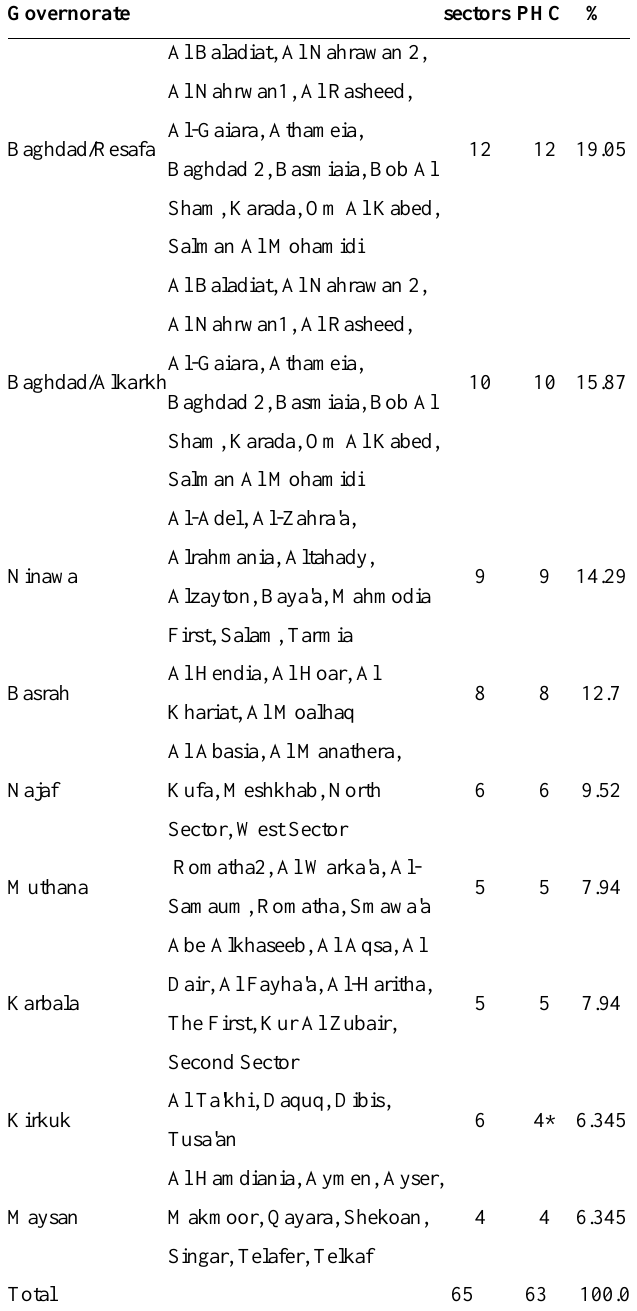
Table 1 : distribution of the studied PHCCs sample Governorate sectors PHC